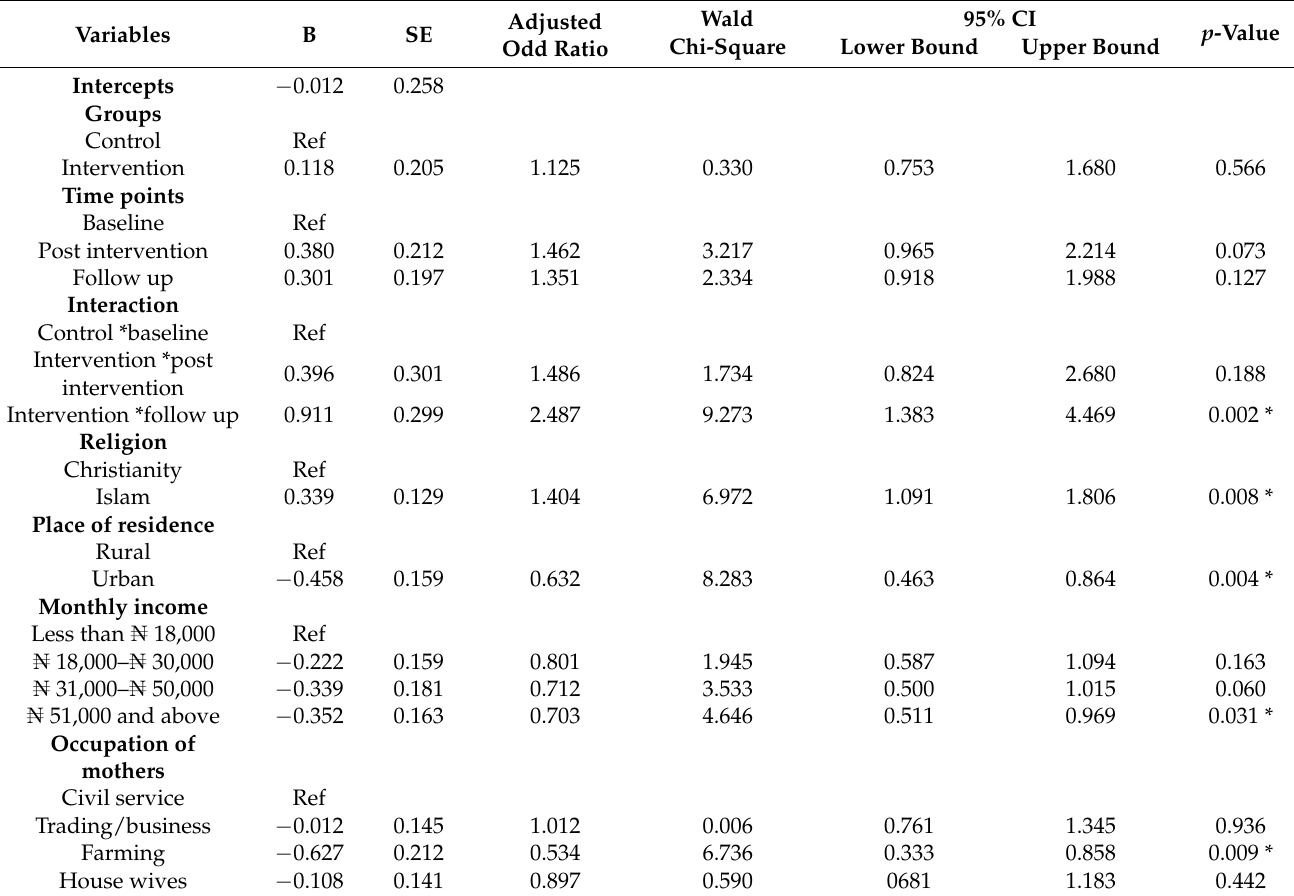
Table 6. Factors associated with WASH practice of respondents using a generalised estimating